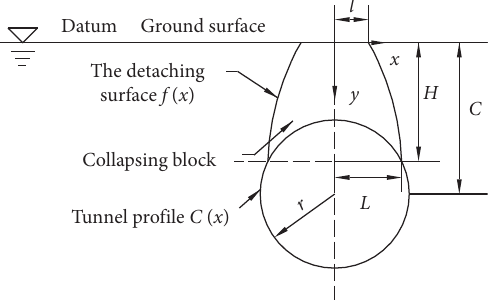
Figure 12: Schematic diagram of collapse mechanism for the shallow tunnel. Figure 13: Schematic diagram of collapse mechanism of the tunnel in layered